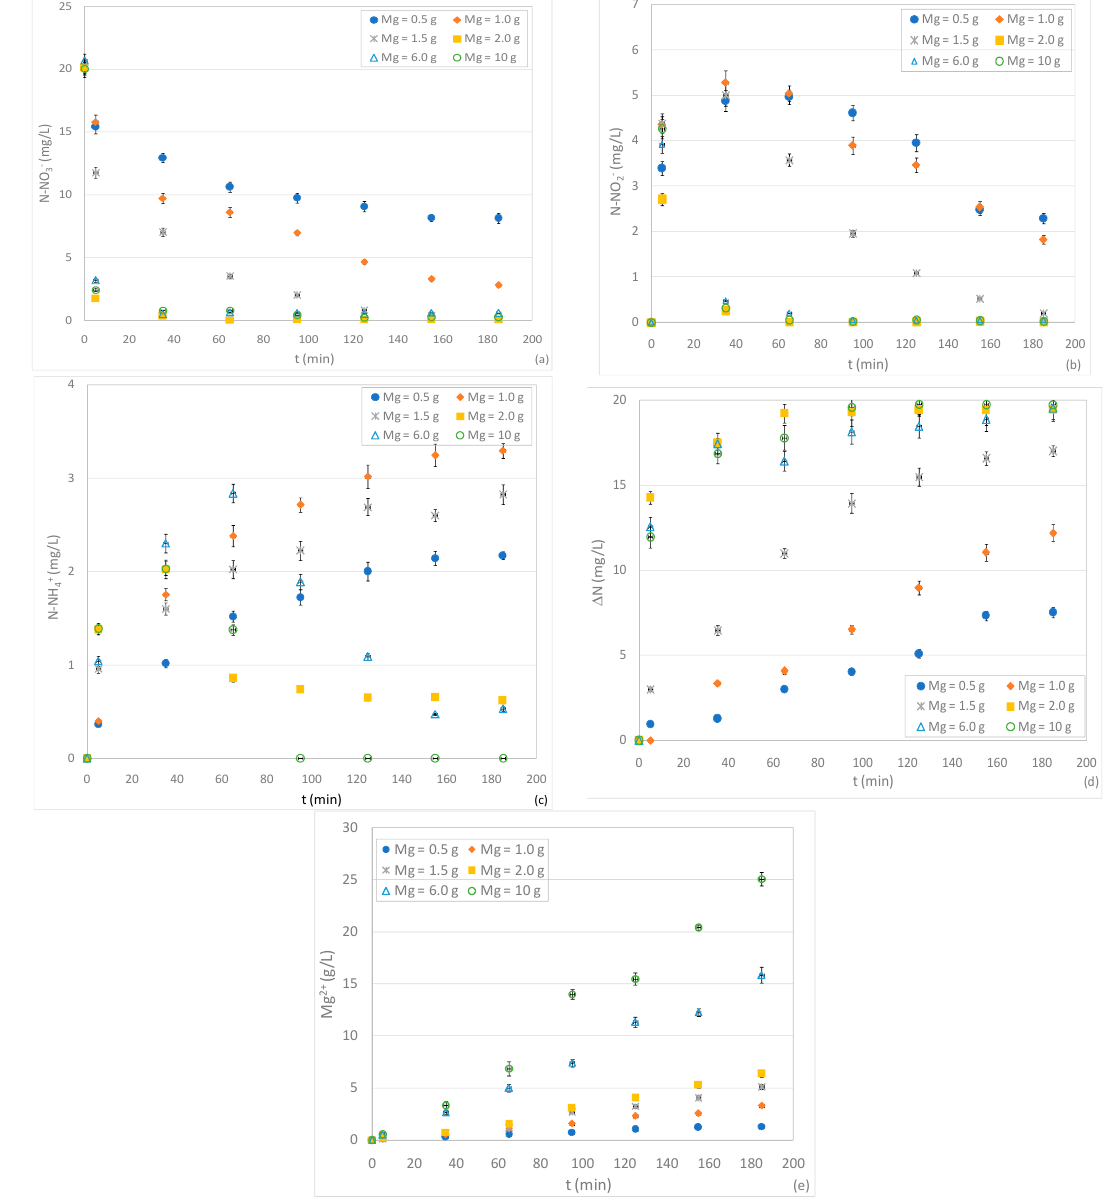
Figure 2. of N-NO 3 − ( a ), N-NO 2 − ( b ), N-NH 4 + ( c ), Δ N ( d ) and Mg 2+ ( e ) during the tests carried out at Figure 2. Concentrations of N-NO 3 − ( a ), N-NO 2 − ( b ), N-NH 4 + ( c ), ∆ N ( d ) and Mg 2 + ( e ) during the tests carried out at pH 3, with an initial N-NO 3 − concentration of 20 mg / L, varying the amount of Mg 0